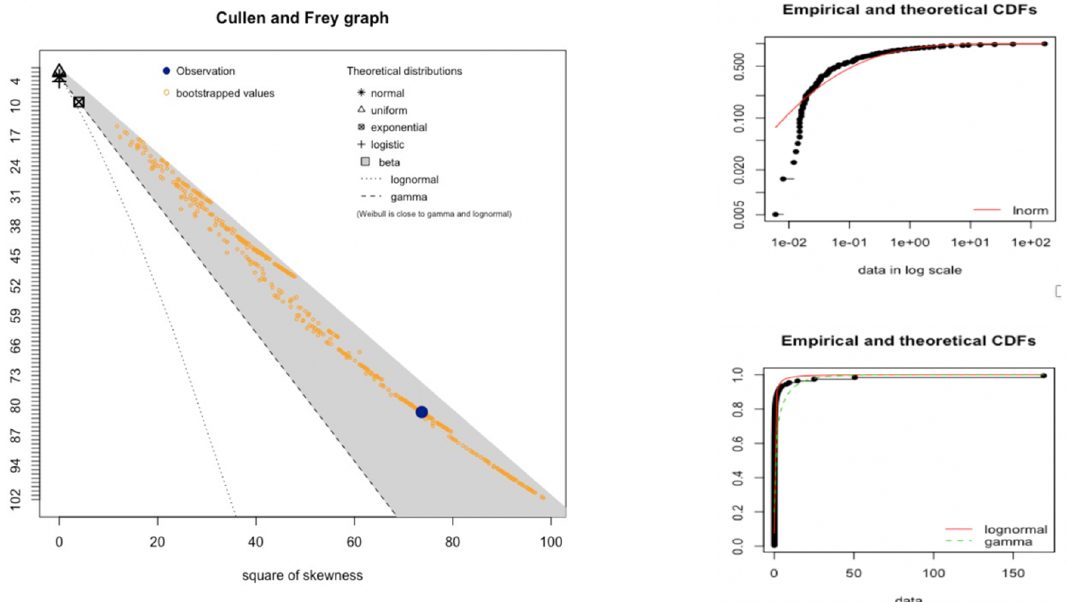
Figure 10. Cullen and Frey graph.